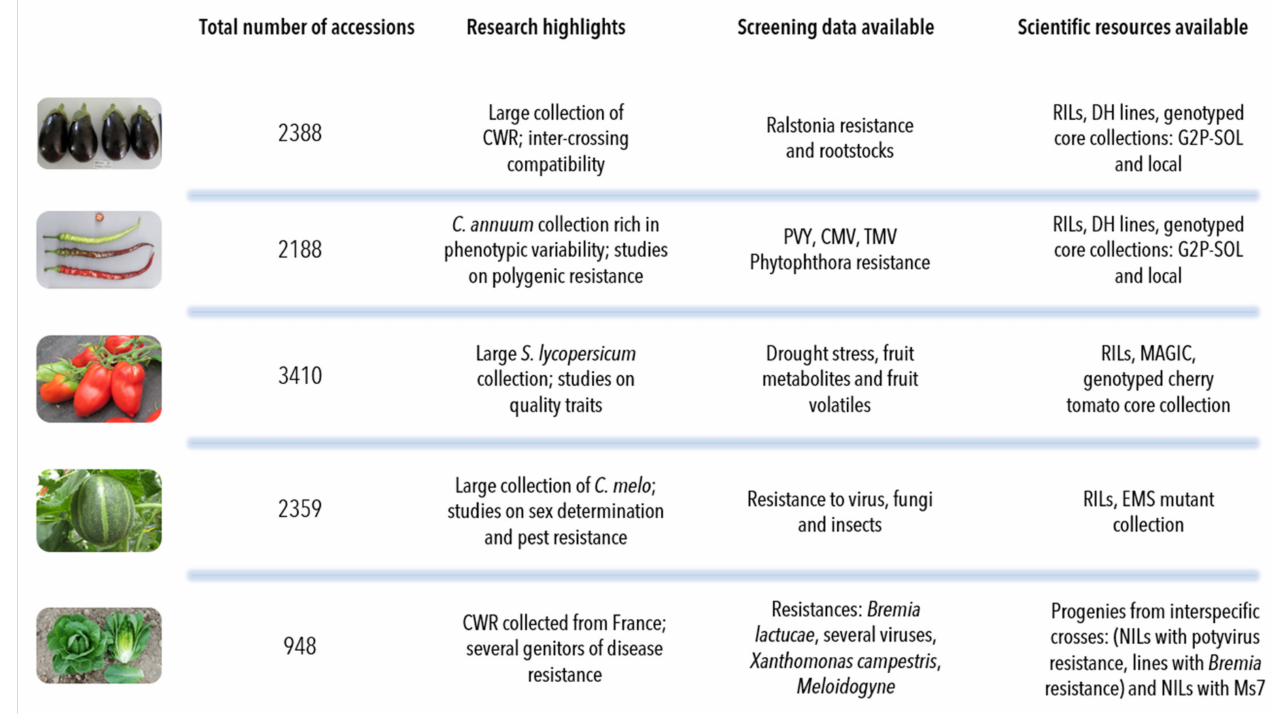
Figure 5. Collection highlights, total number of accessions, screening data and scientific resources available for each of the five